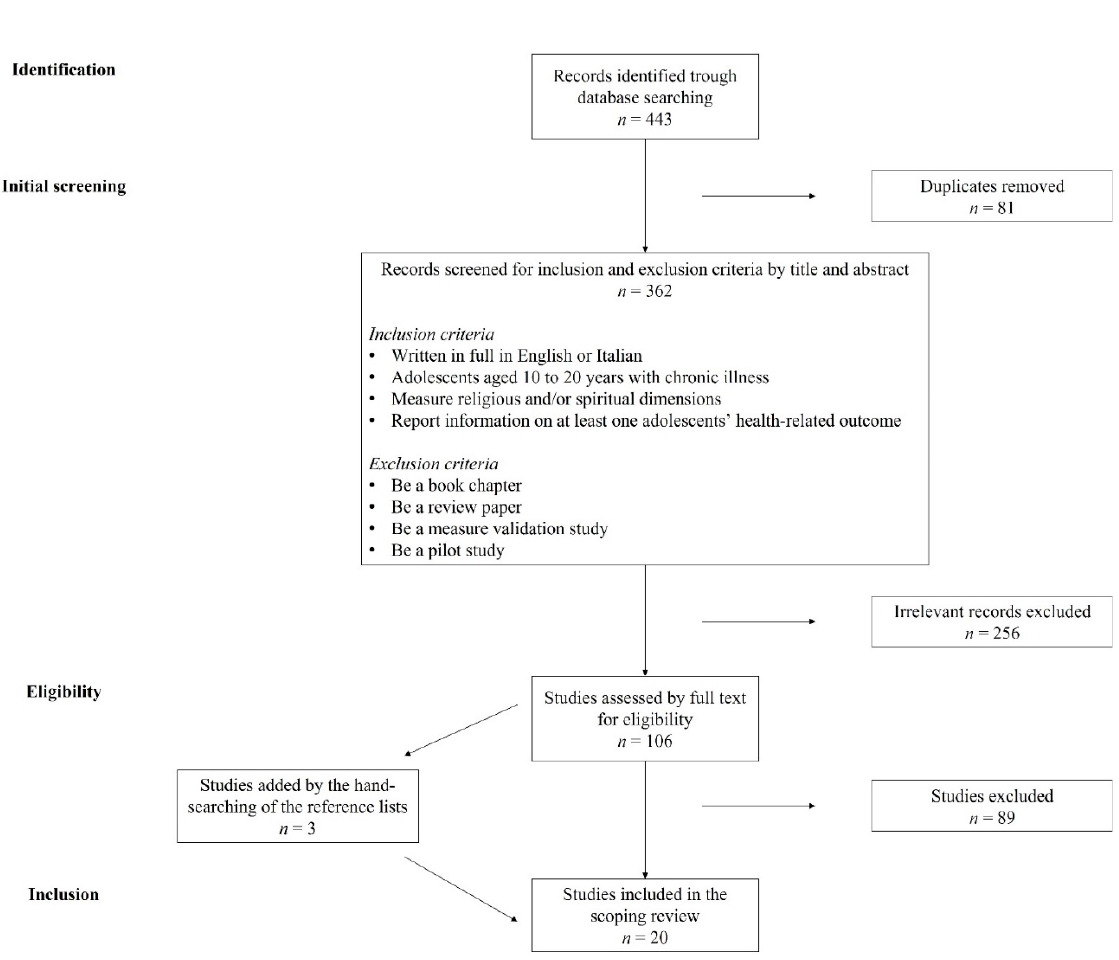
Figure 1. PRISMA diagram illustrating the literature selection process.